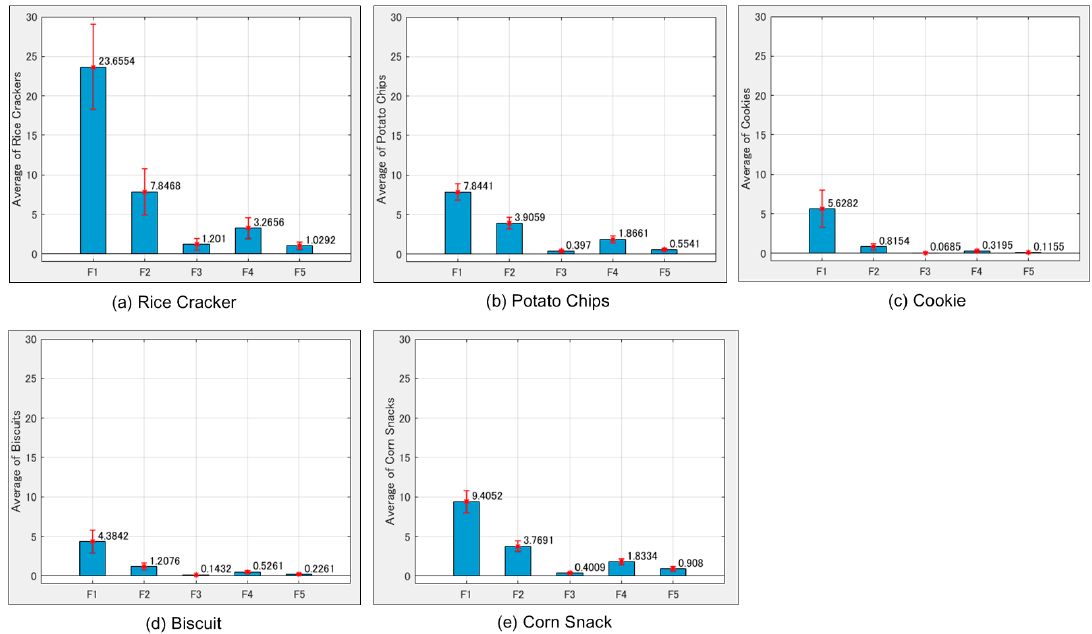
Figure 9. Averages and STDs of F1–F5 for ( a ) the rice cracker; ( b ) potato chips; ( c ) cookie; ( d ) biscuit and; ( e ) corn snack.